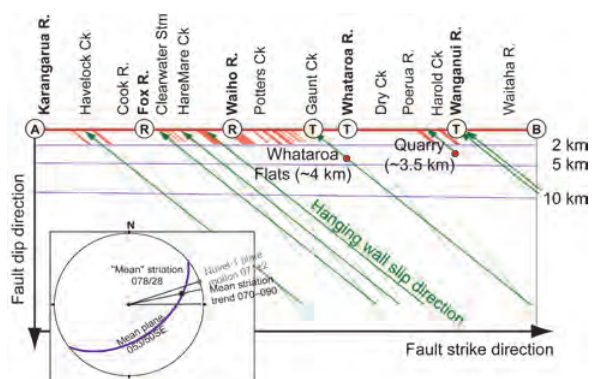
Figure 4. Schematic view normal to the mean fault plane in the central Alpine Fault region showing rock uplift trajectories and key outcrop locations. Place names shown in bold correspond to prospective drill sites. “A” (southwest) and “B” (northeast) are marked on Figure 1 for reference. “T” and “R” denote tracks and roads, respectively, crossing the fault trace. The short red lines mark strike-slip sections of the fault trace. The inset summarizes the mean fault geometry in stereographic